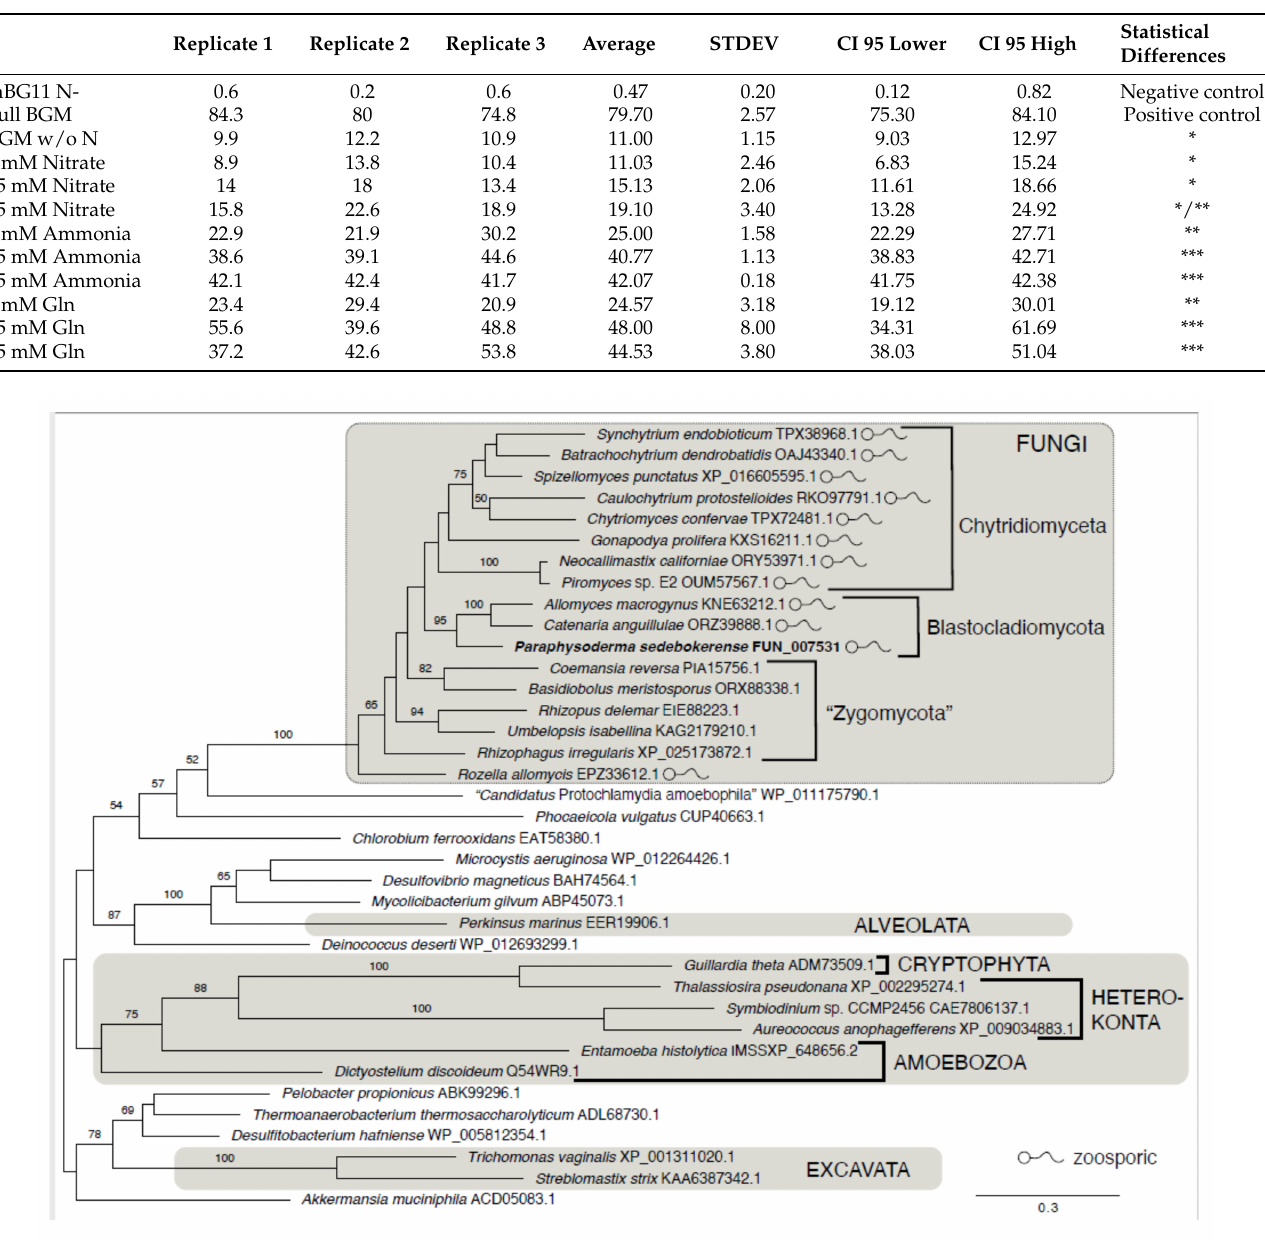
Table 1. Wet weight of P. sedebokerense cultures inoculated with different nitrogen sources obtained after 10 days of growth (values are expressed in mg). Data were obtained from the experiment shown in Figure 6. Asterisk symbols refer to statistical differences as non-overlapping confidence intervals.